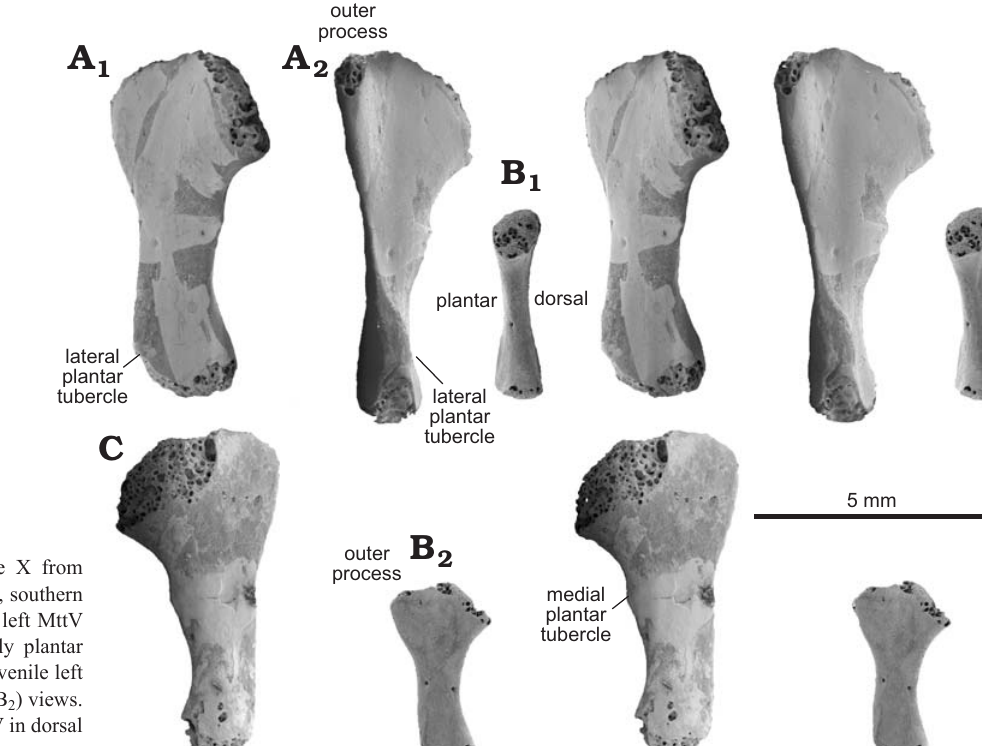
Fig. 5. Sauria indet. morphotype X from the Lower Triassic of Czatkowice, southern Poland. A . ZPAL RV/1991, adult left MttV in plantar (A 1 ) and lateral-slightly plantar (A 2 ) views. B . ZPAL RV/1354, juvenile left MttV in medial (B 1 ) and plantar (B 2 ) views. C . ZPAL RV/1992, adult left MttV in dorsal view. SEM